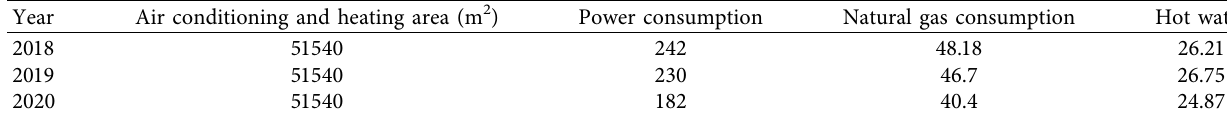
Table 4: Annual building energy consumption.